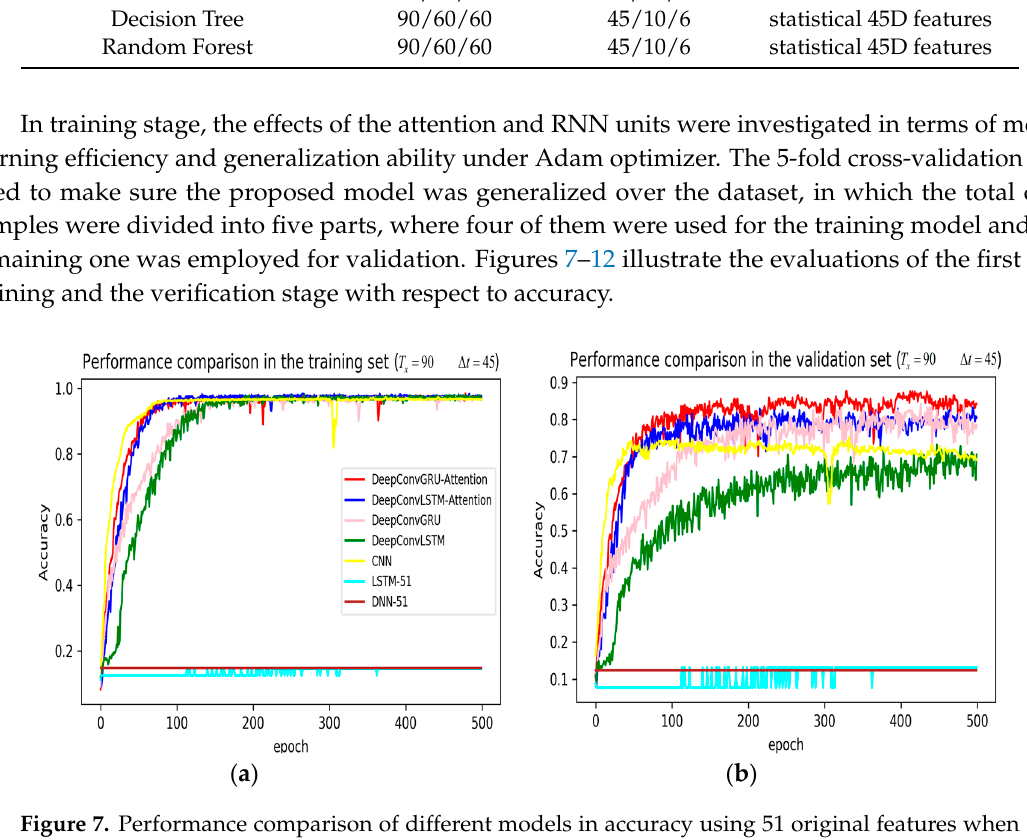
( b ) Figure 8. Performance comparison of different models in accuracy using 51 original features when setting x T to 60 samples and t Δ to 10 samples. ( a ) Performance comparison in the training stage. ( b ) Performance comparison in the validation stage.